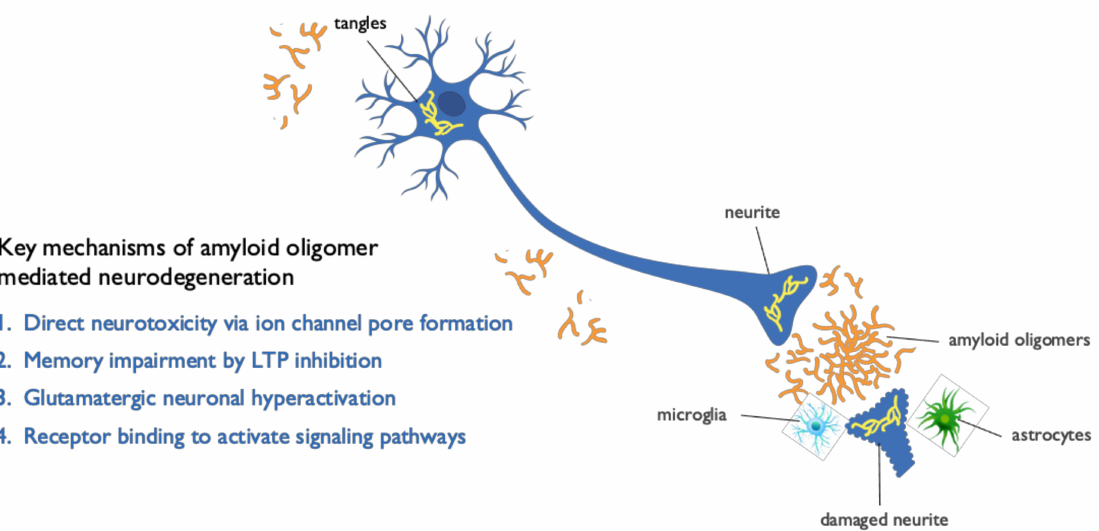
Figure 2. Mechanisms mediating neurotoxicity of amyloid oligomers. Beta amyloid (A β ) oligomers mediate multiple pathogenic mechanisms in Alzheimer’s disease (AD) that lead to neuronal cell dysfunction and death, including direct synaptic and cell toxicity, neuronal hyperactivation, inhibition of long-term potentiation (LTP), tau hyperphosphorylation, microglial activation, and